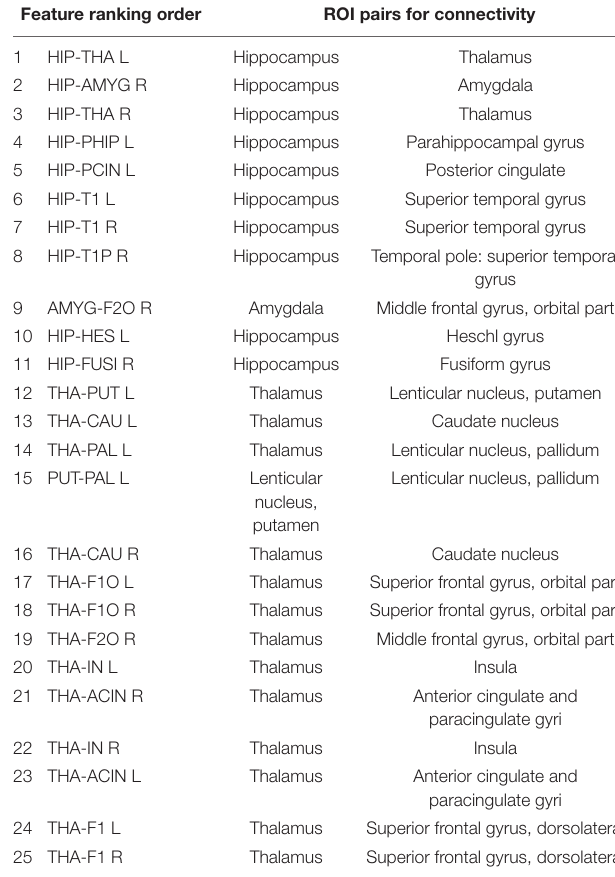
TABLE 4 | Feature ranking order for WM